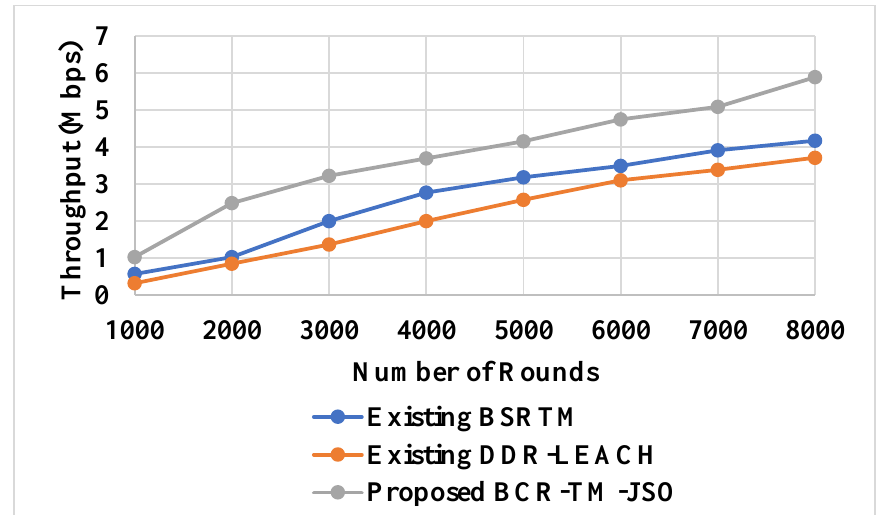
Figure 6. Performance of throughput with existing methods [21, 25]. Table 3. Performances of